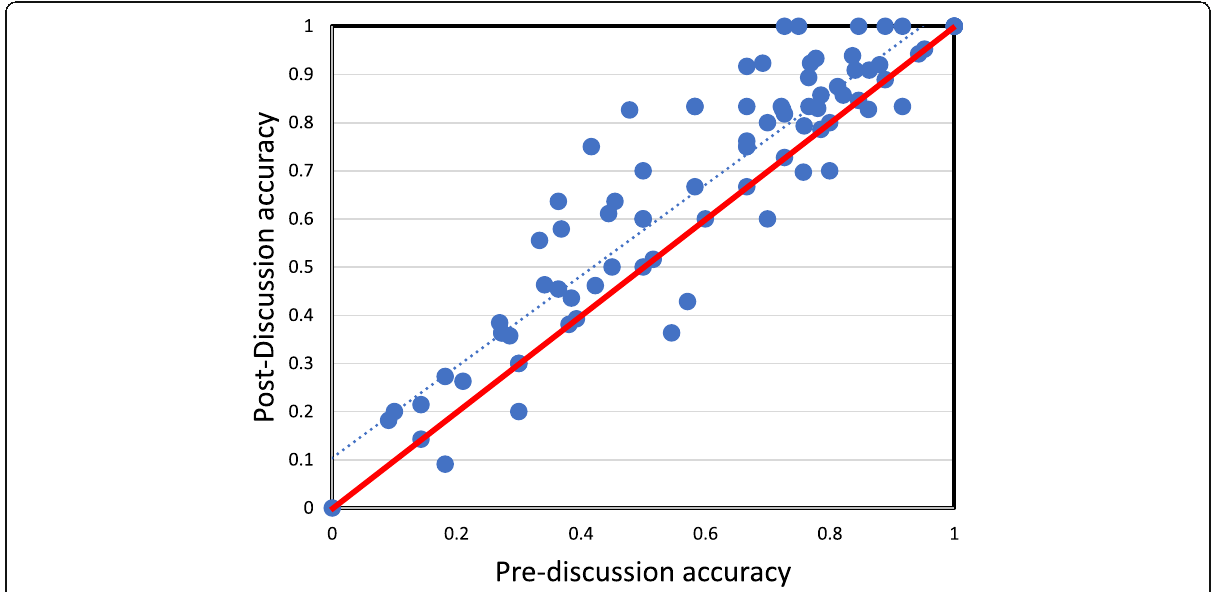
Fig. 1 The relationship between pre-discussion accuracy (x axis) and post-discussion accuracy (y axis). Each point represents a single question. The solid diagonal line represents equal pre-discussion and post-discussion accuracy; points above the line indicate improvements in accuracy and points below represent decrements in accuracy. The dashed line indicates the line of best fit for the observed